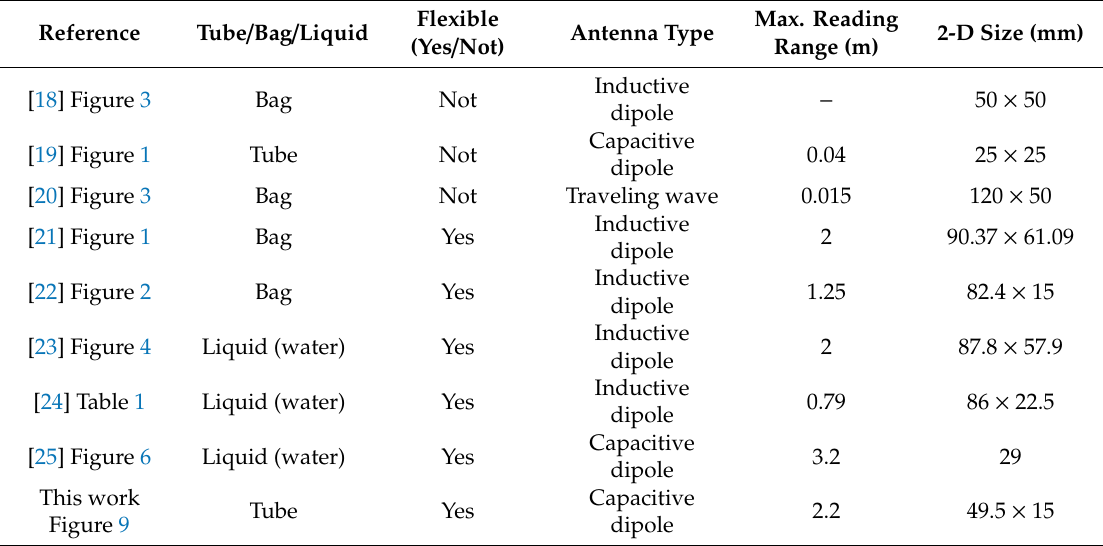
Table 2. Comparison between the proposed RFID tag and other designs for blood and liquid